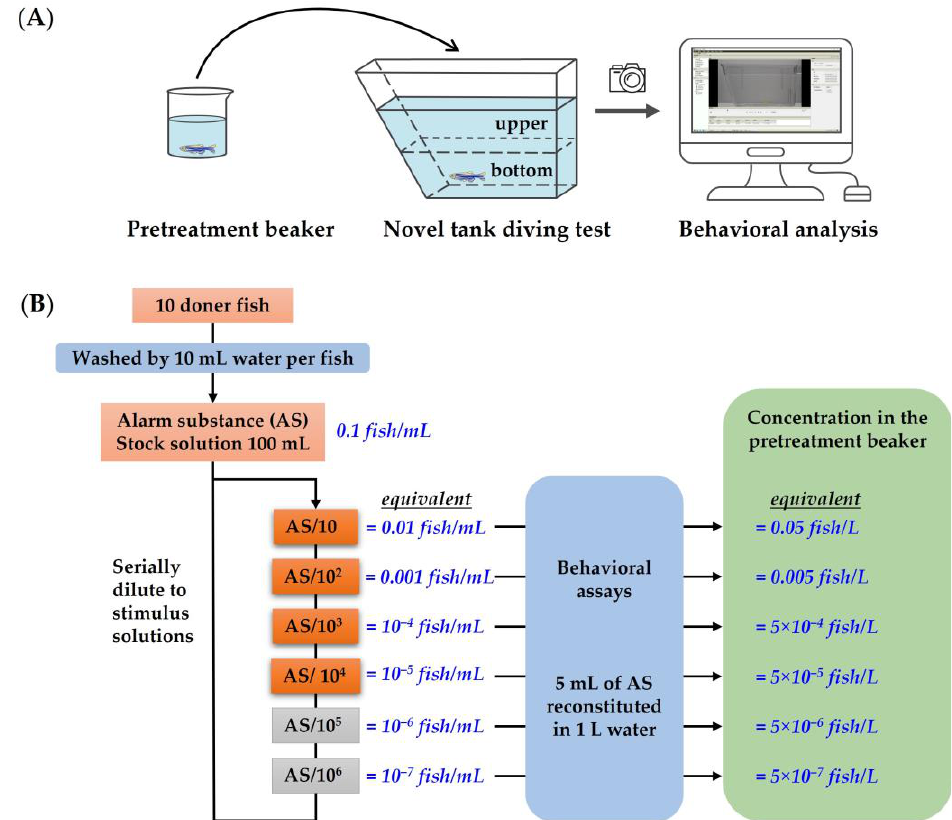
Figure 1. Schematic diagram of behavior test and data analysis of zebrafish. ( A ) Alarm substance (AS) dilution strategy from zebrafish skin. ( B ) The orange boxes represent the treatment with behavioral activities; the grey boxes represent inactive fractions; and the blue boxes present dilution steps. The black arrows represent the dilution procedure of AS in the experiments. Finally, the equivalent concentrations in the pretreatment beaker have been expressed in the green